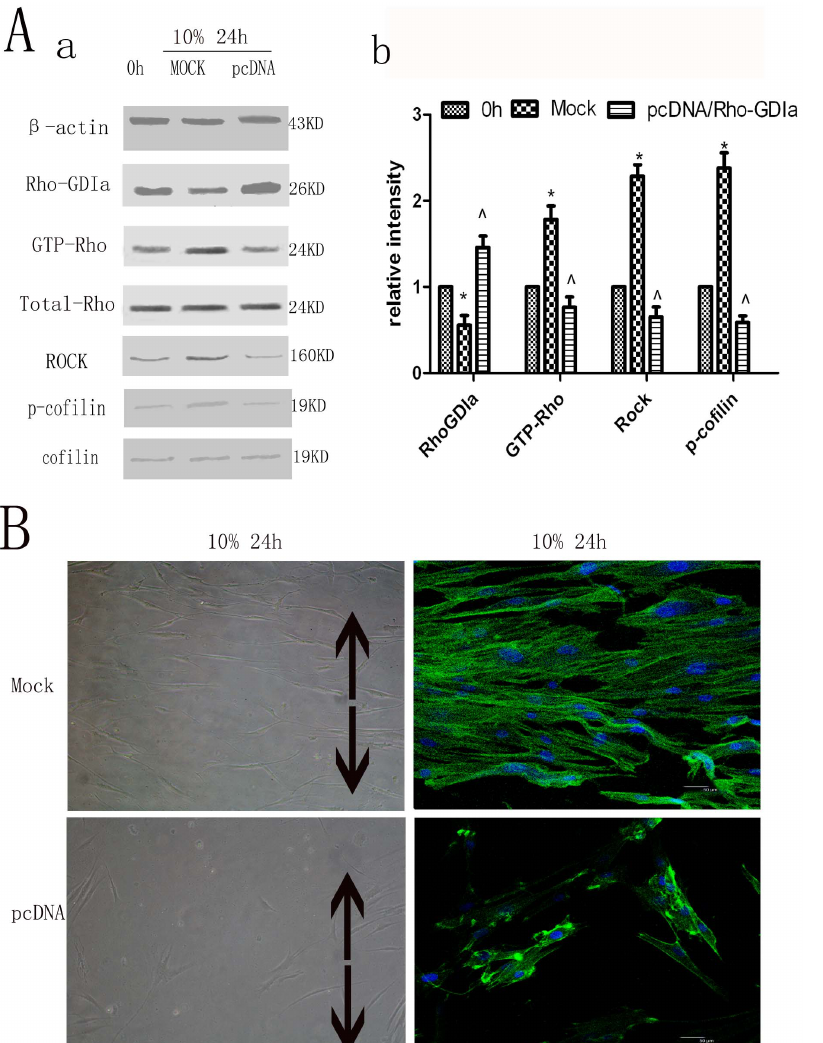
Figure 4. Overexpression of Rho-GDP dissociation inhibitor alpha and its effects on the expression of Rho signaling pathway proteins. Overexpression of Rho-GDP dissociation inhibitor alpha on Rho-GDIa, GTP-Rho, Rock and p-cofilin protein expression. The protein expression levels of Rho-GDIa after transfection with the pcDNA/Rho-GDIa group were significantly greater than those in the Mock group, while the expression levels of GTP-Rho, Rock and phospho-cofilin were less than those in the Mock group. Values shown are the mean 6 SD for each group